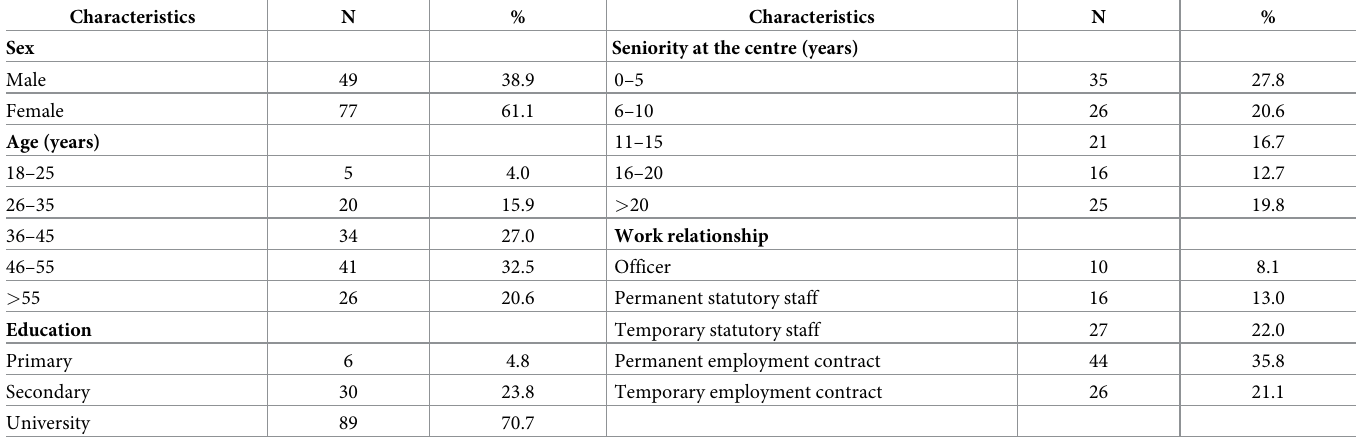
Table 1. CTS staff sample